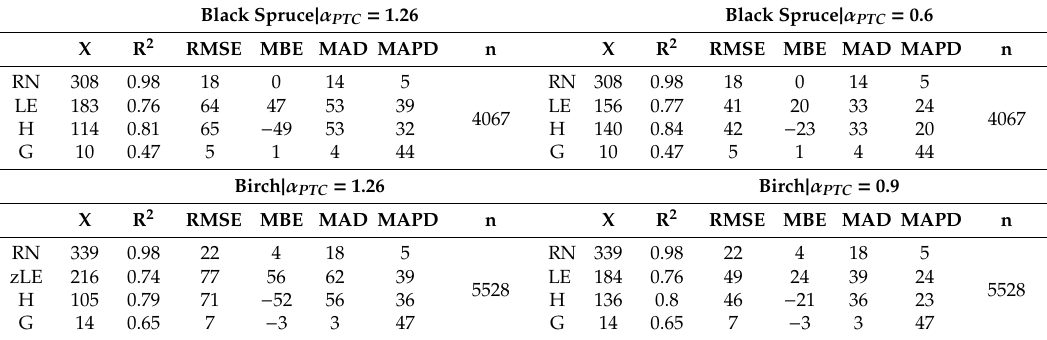
Table 2. Results of the model agreement and error estimation compared to observed flux tower data using an initial TSEB α PTC value of 1.26 at both settings, 0.6 for black spruce setting, and 0.9 for birch setting. n is the number of 30-min periods selected. Error estimators (RMSE, mean absolute di ff erence (MAD), MBE) are in W · m − 2 while MAPD is in %. G was modelled using c GT in Equation (18) applied to Equation (14). X are the mean values for the estimated energy balance components in W · m − 2. Black Spruce | α PTC = 1.26 Black Spruce | α PTC =